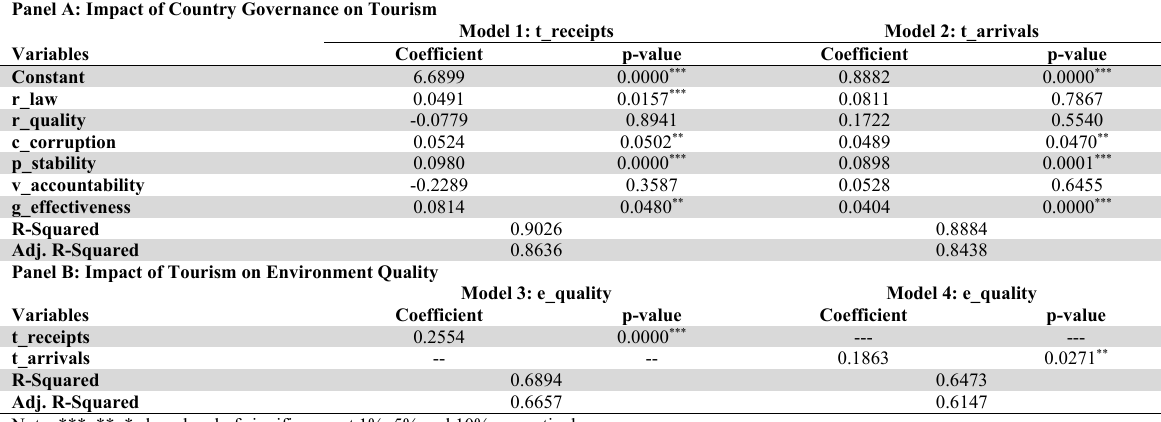
Regression Analysis Panel A: Impact of Country Governance on